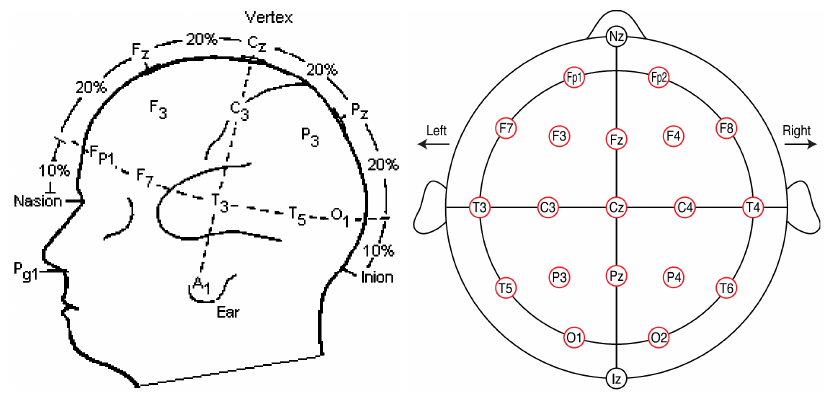
Figure 7. EEG electrode placement locations